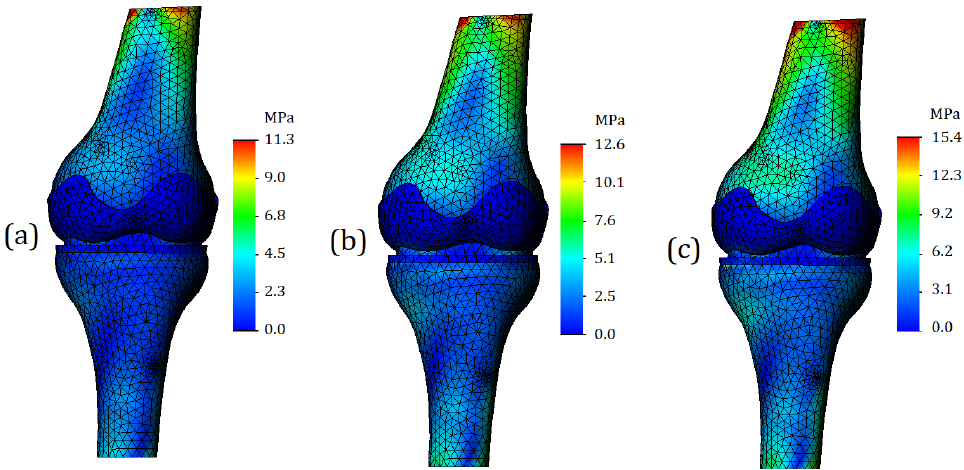
Figure 6. Von Mises stress plots in case of walking. General view of the model: ( a ) With mild cartilage stiffness; ( b ) With moderate cartilage stiffness; ( c ) With severe cartilage stiffness. The finite element model section-view for the bone components is shown in Figure 7.